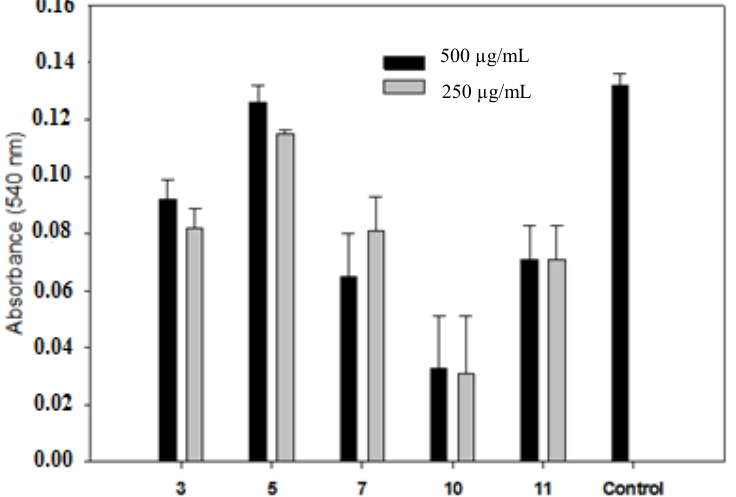
Figure 2. Cytotoxicity of compounds dissolved in DMSO after 24 h of cell exposure. Compounds showed statistically similar cytotoxicity